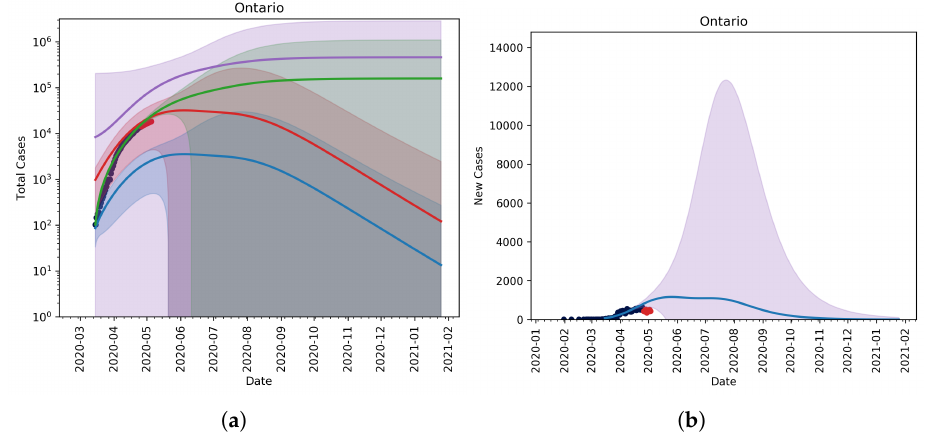
Figure A3. The model projections from the first wave of COVID-19 in Ontario. The red dots are data not used in the model fitting. The green line is the cumulative known cases, purple is the total incidence, red is active mild cases, and blue is active severe cases. In the right panel ( b ), we see the new cases per day. We see that the model performs well for at least two weeks when non- pharmaceutical interventions remain relatively constant. The shaded region is the 95% confidence interval from the fit. The 95% confidence interval was able to detect the presence of a second wave in the